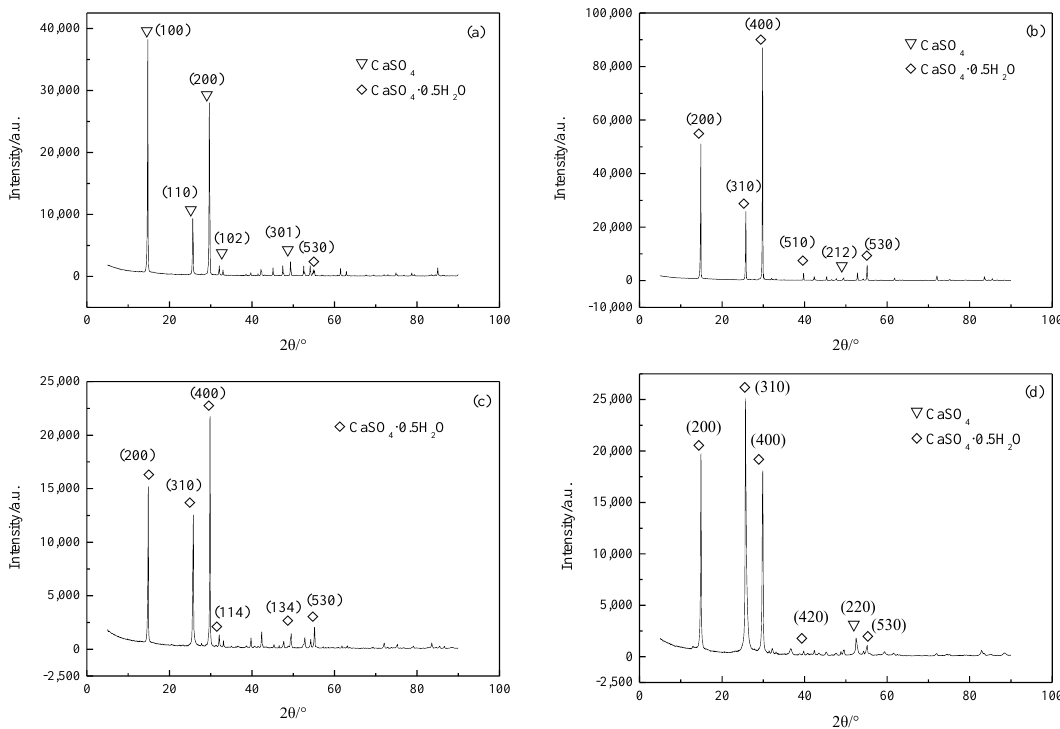
Figure 4. Diffraction strength of the crystal faces ( a ) with the absence of additives, ( b ) with sodium oleate, ( c ) with SDBS, and ( d ) with sodium citrate.